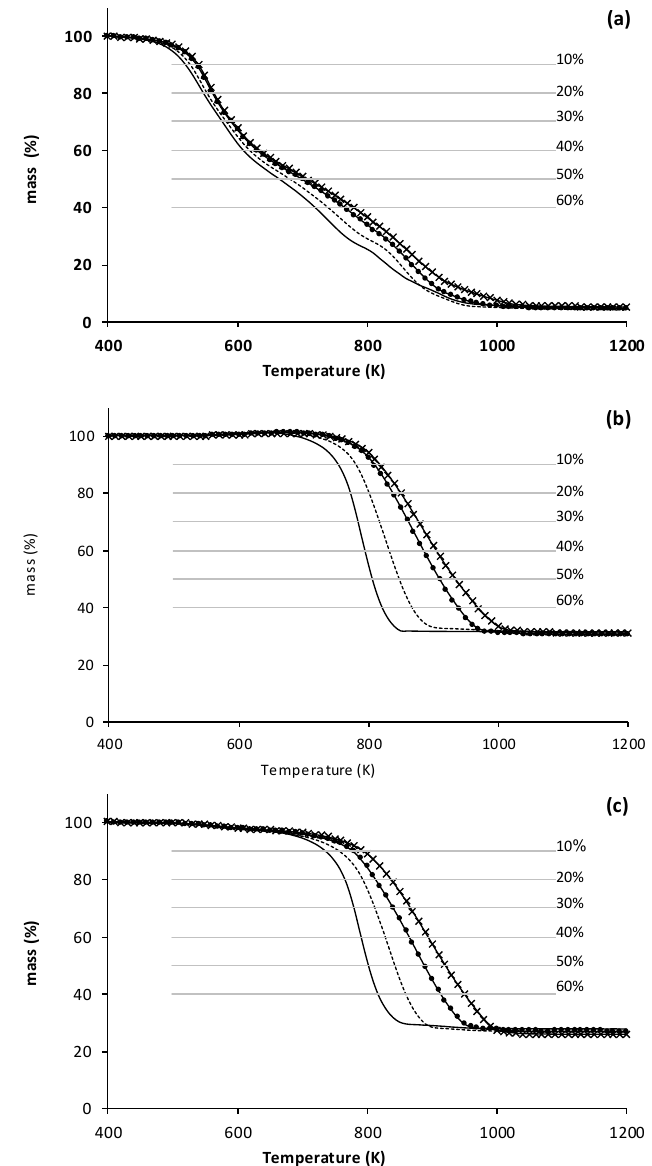
Figure 4. Thermogravimetry (TG) curves corresponding to the combustion of MB ( a ), BC ( b ), and MB-BC ( c ) at different heating rates. Conversion percentages (10, 20, 30, 40, 50, and 60%) have been marked by straight lines crossing experimental data.